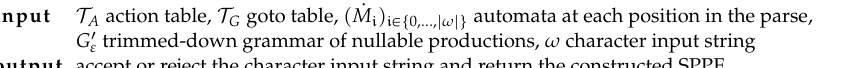
Algorithm 2. RNGSGLR (0,1] parser for character-level